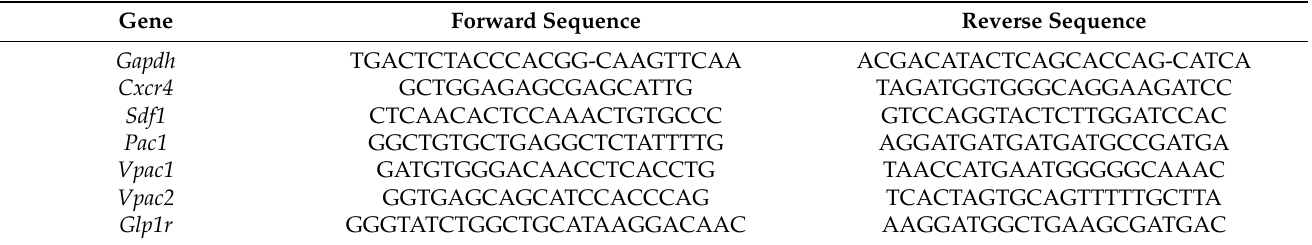
Table 4. Primers’